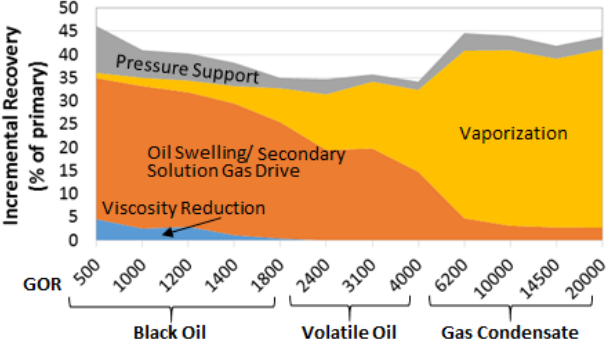
Figure 16. Incremental recovery as a percentage of primary, further broken down by recovery mechanisms.